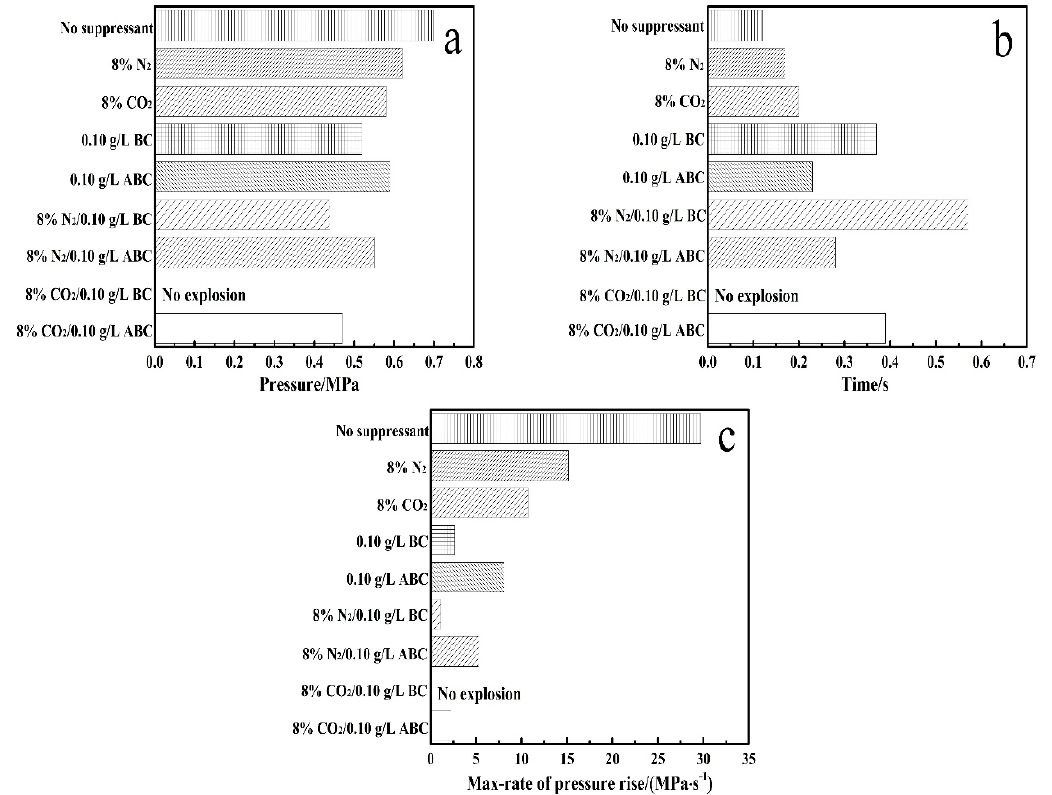
Figure 5. The suppression effects of different inhibitors: ( a ) the max-pressure; ( b ) the time to max-pressure; ( c ) the maximum rate of pressure rise. Table 2. The methane explosion parameters with different inhibitors.